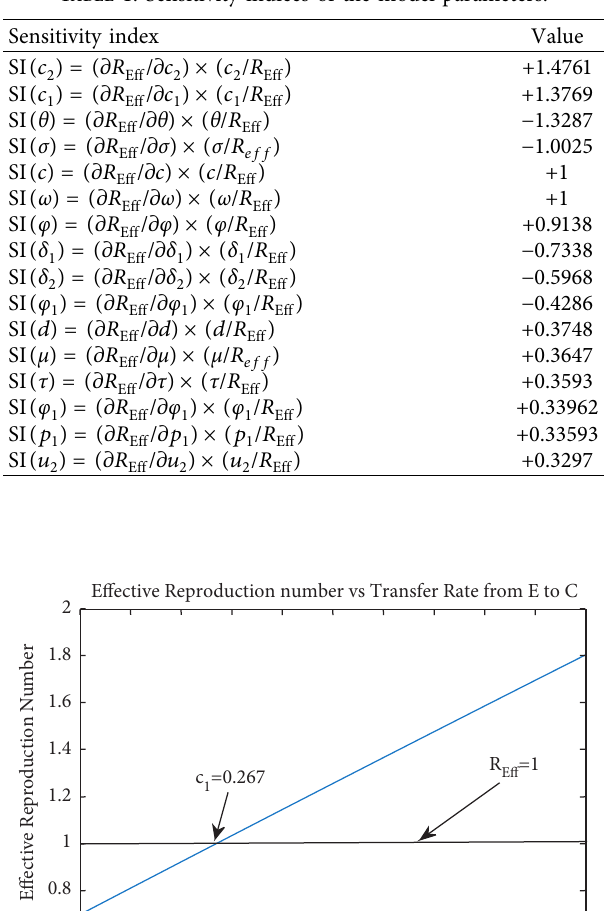
Figure 2: Behavior of SEACTR model at endemic equilibrium point. Table 1: Sensitivity indices of the model parameters.